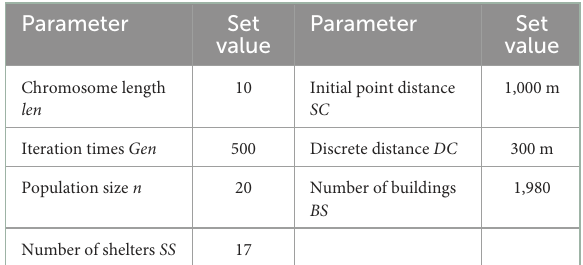
TABLE 3 Parameter setting value